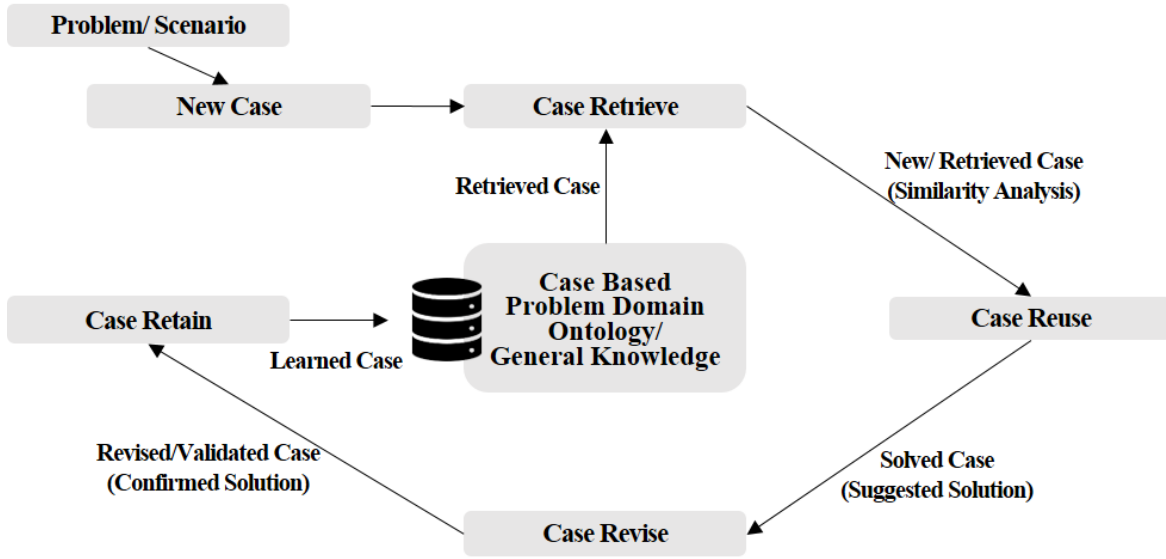
Figure 1. Cycle of CBR (adapted from [18]).